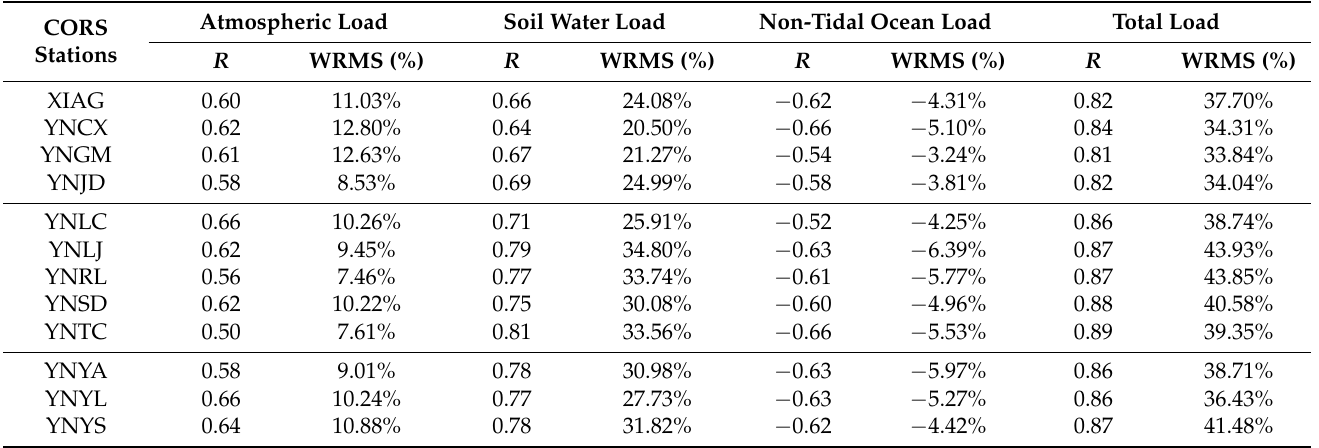
Table 4. Correlation coefficient and WRMS values between different loads and the reconstructed geodetic height time